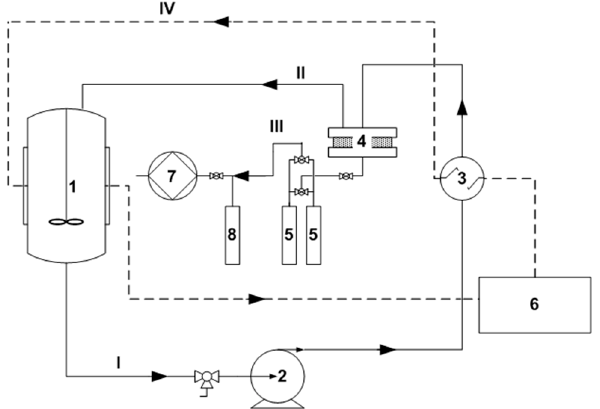
Figure 2. Scheme of the vacuum pervaporation setup: 1—a container with a mixing device; 2—a gear pump; 3—a heat exchanger; 4—a membrane module; 5—traps for collecting permeate, placed in Dewar vessels with liquid nitrogen; 6—thermostat; 7—vacuum pump; 8—safety trap; I—initial separable mixture; II—retentate; III—permeate; IV—coolant.